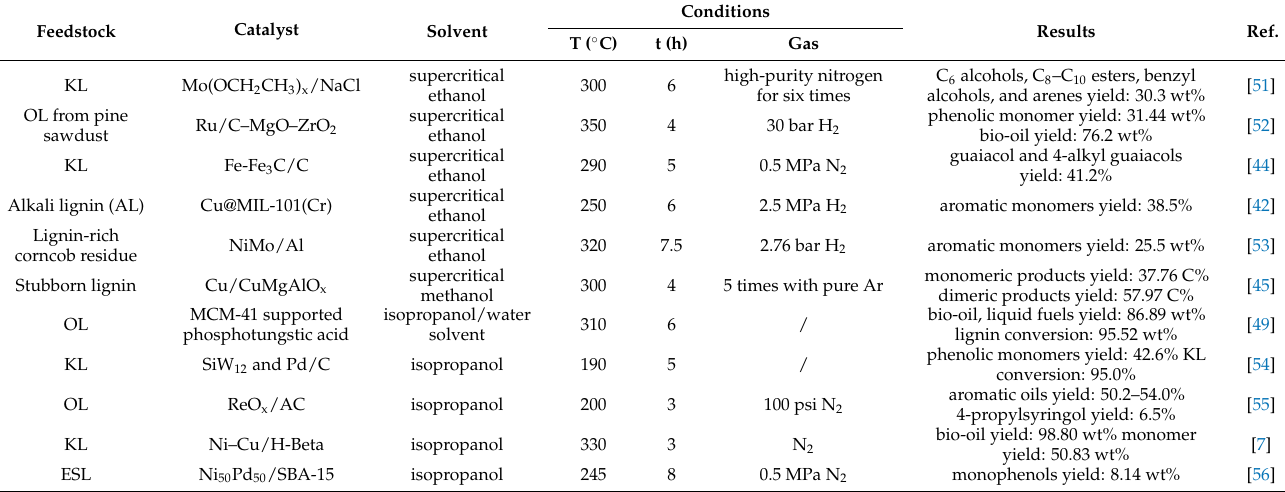
Table 2. Summary of catalytic depolymerization of lignin involving